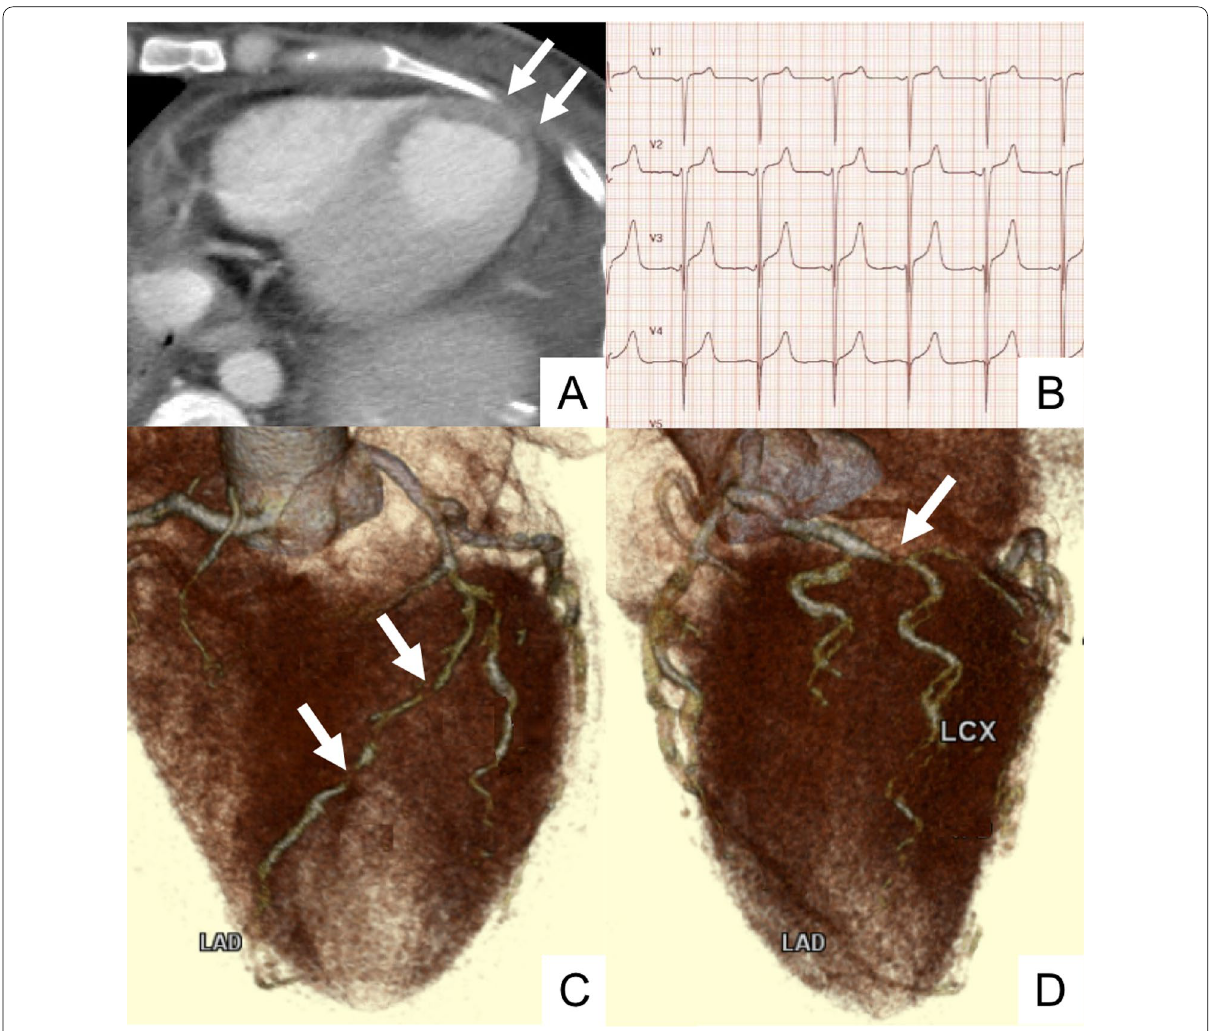
Fig. 2 Cardiovascular evaluation. A Poor contrast enhancement in the apex (white arrow) on CT on POD 7. B ST elevation in leads V1–4 on the electrocardiogram on POD 9. C Suspicious stenosis in the left anterior descending artery on coronary CT angiography on POD 13 (white arrow). D Suspicious stenosis in the left circumflex artery on coronary CT angiography on POD 13 (white arrow). AV AV node artery, CT computed tomography, LAD left anterior descending artery, LCX left circumflex artery, PD poster descending branch, POD postoperative